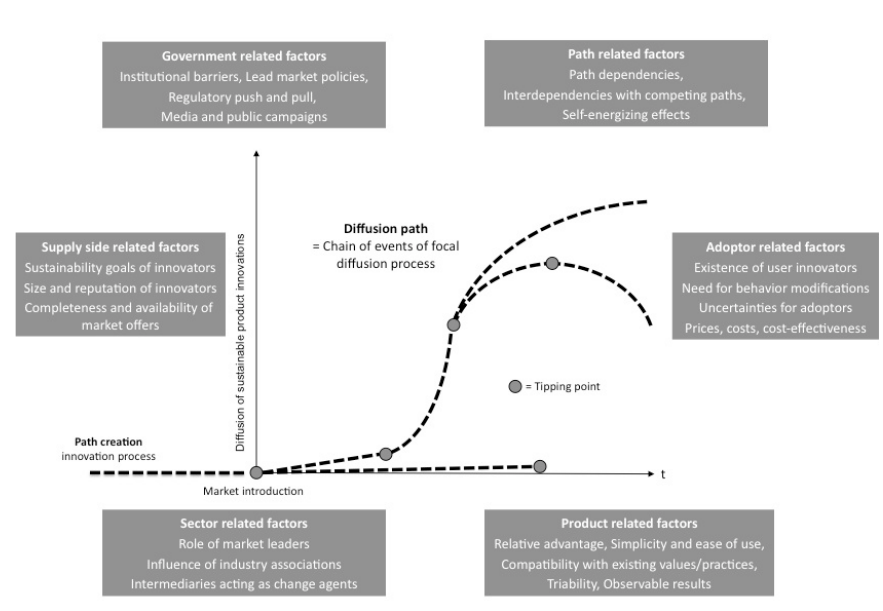
Fig. 1. Research framework for analyzing the diffusion of sustainable